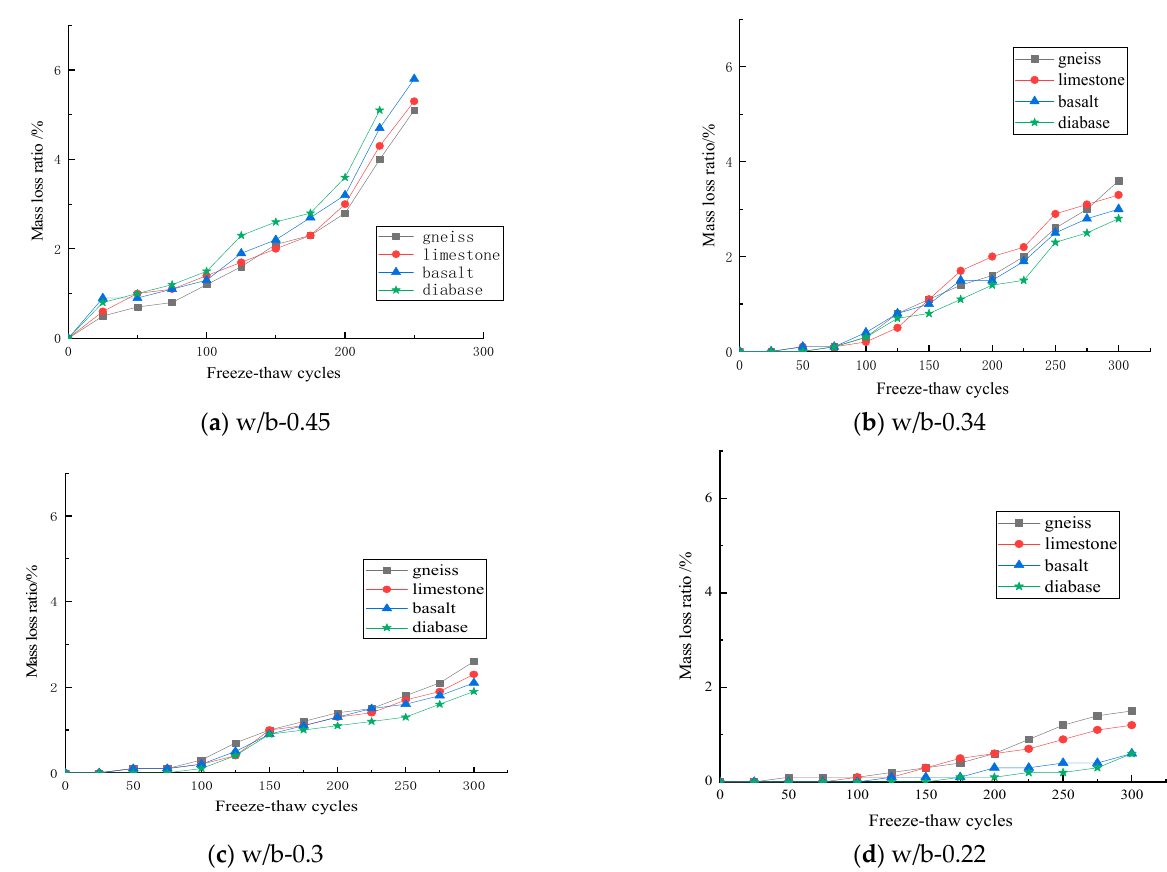
Figure 9. The mass loss ratio during freeze–thaw cycles: ( a )water-binder ratio of 0.45; ( b ) water-binder ratio of 0.34; ( c ) water-binder ratio of 0.30 and ( d ) water-binder ratio of 0.22.